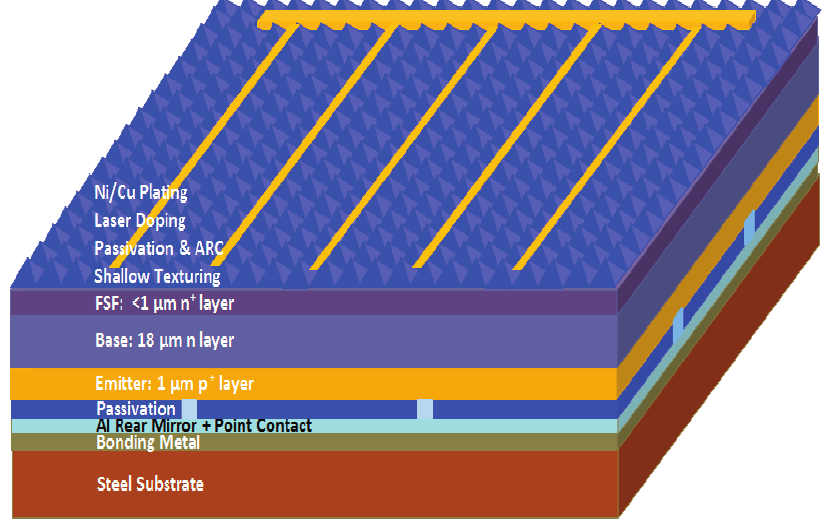
Figure 1. Diagram of the UTSi solar cell on steel substrate